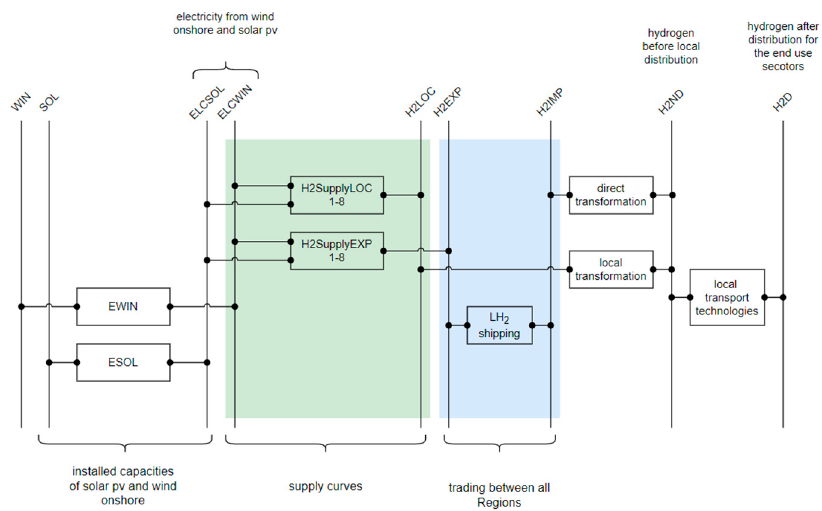
Figure 3. Implementation of aggregated cost supply curves shown on the example of hydrogen.